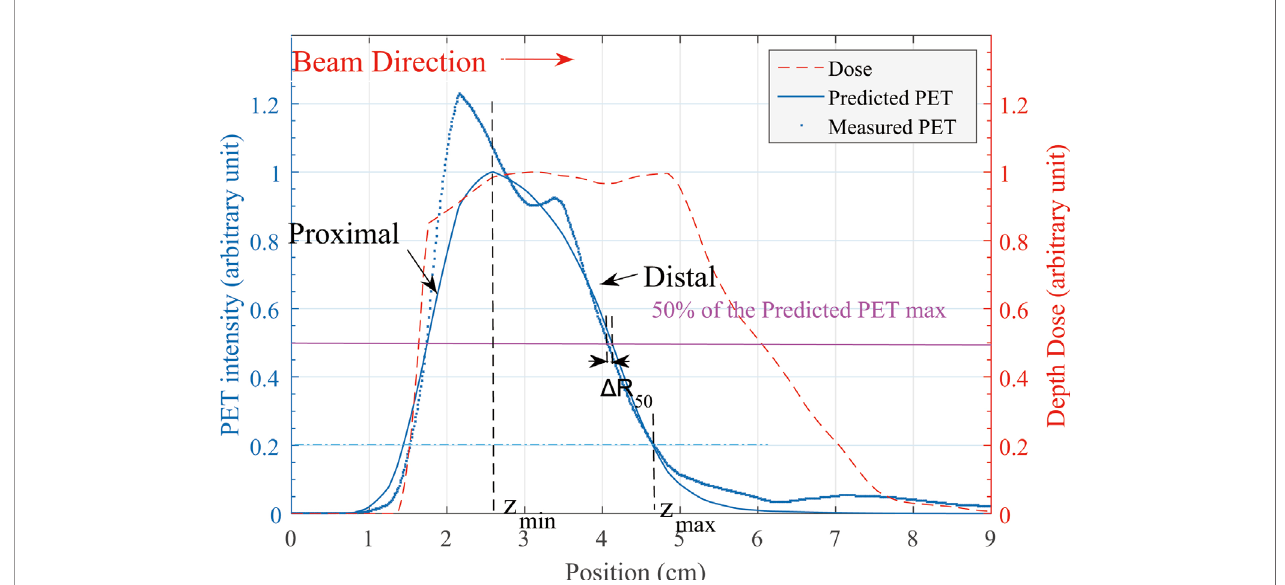
FIGURE 2 | Predicted and measured PET 1-D curve. Along the beam direction, the depth error at distal edge is our concern. De fi nition of D R 50 is shown in this fi ned on the predicted PET fi gure. z min and z max location of the R shift method is de